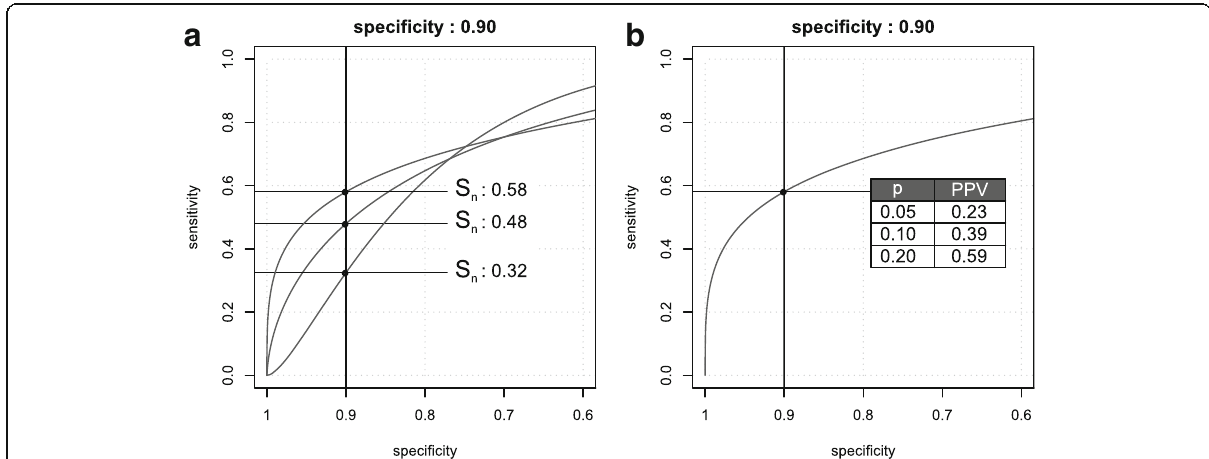
Fig. 2 Sensitivity and PPV at a given specificity. a Sensitivity at a given specificity ( S p = 0.90) for three ROC curves with the same AUROC (full ROC curves shown in Fig. 1). b PPV as a function of disease prevalence ( p = 0.05, 0.10, 0.20) for given specificity ( S p = 0.90) and sensitivity ( S n =